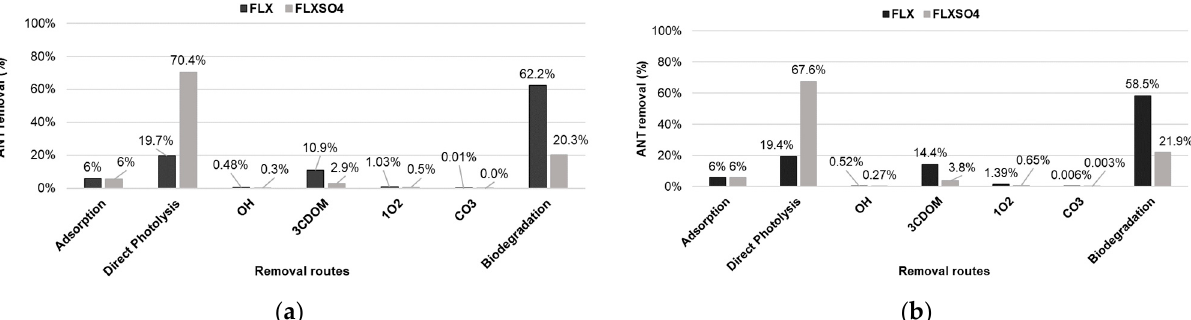
Figure 5. Contribution of each degradation pathway in the removal of the pollutants from the reservoir water. ( a ) June; ( b ) September.